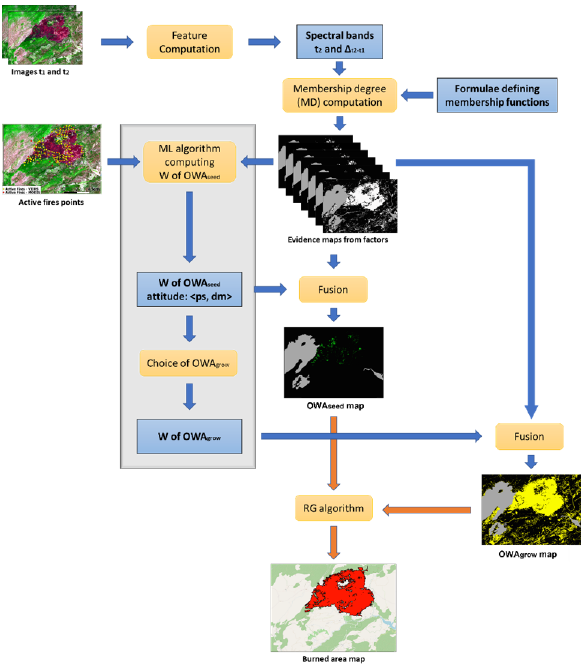
Figure 4. Workflow of the fully automatic algorithm proposed for burned area mapping with the multi-criteria adaptive approach. The grey box highlights the innovative step in the algorithm introduced to fully automatize the definitions of both OWA seed and OWA grow , generating the seed and grow layers, respectively, and used in input by the RG